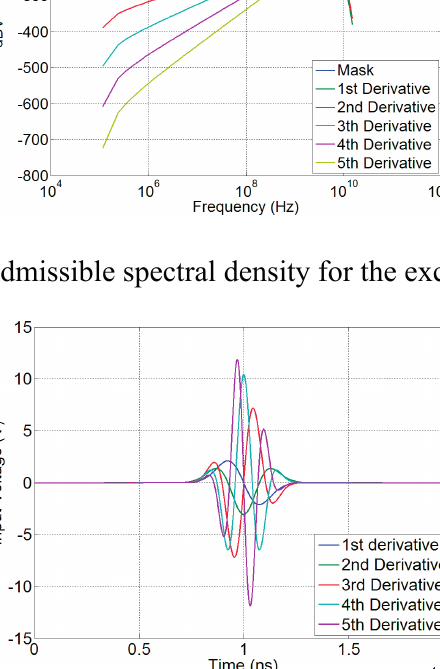
Figure 9. Pulse time evolution for the first five derivatives of the Gaussian